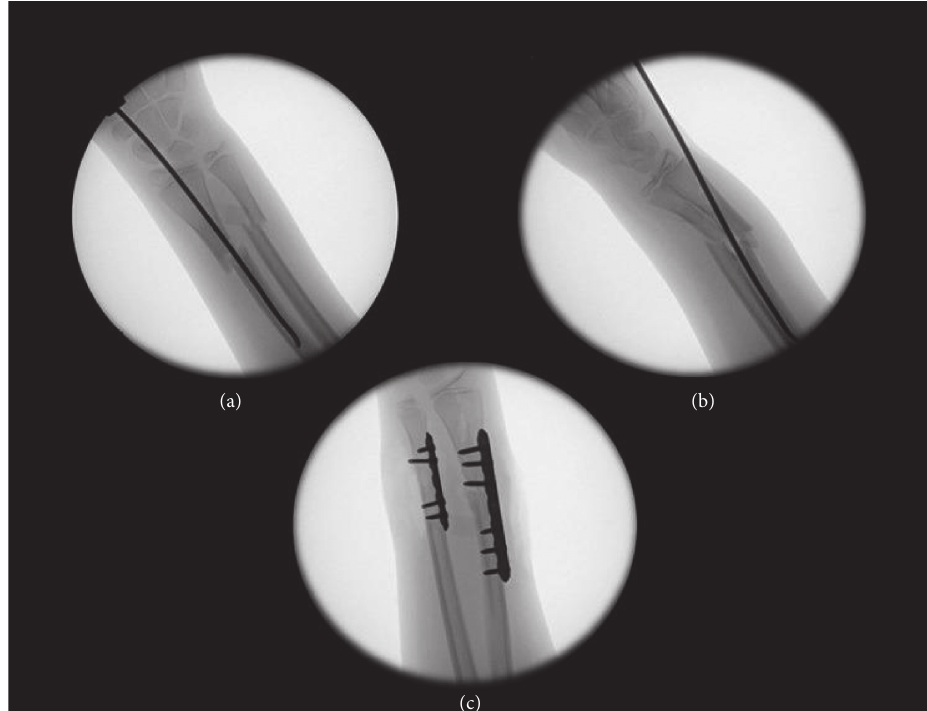
Figure 4: (a, b) Intraoperative fluoroscopic images showing two views of flexion deformity and translation at the fracture site induced by ulnar entry of the FN. (c) Intraoperative fluoroscopic image showing the change of the fixation method to plate